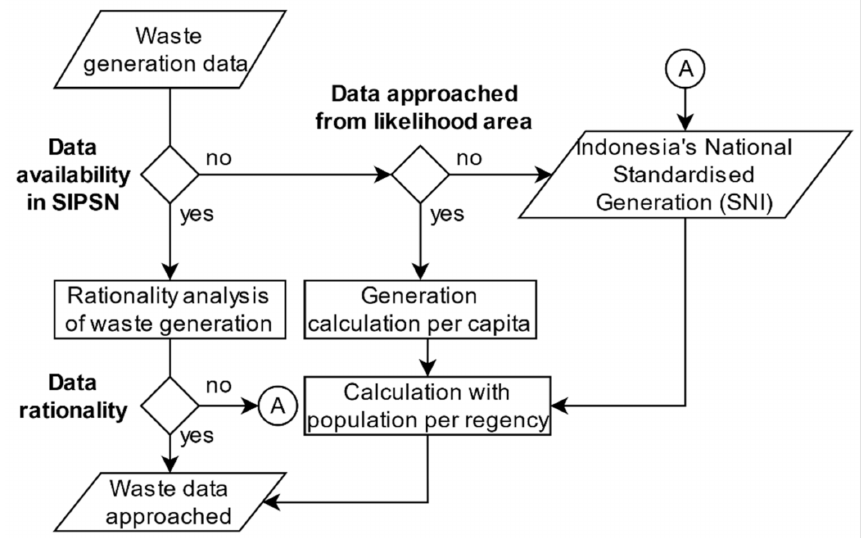
Figure 3. A flowchart of data source selection with area boundaries of the